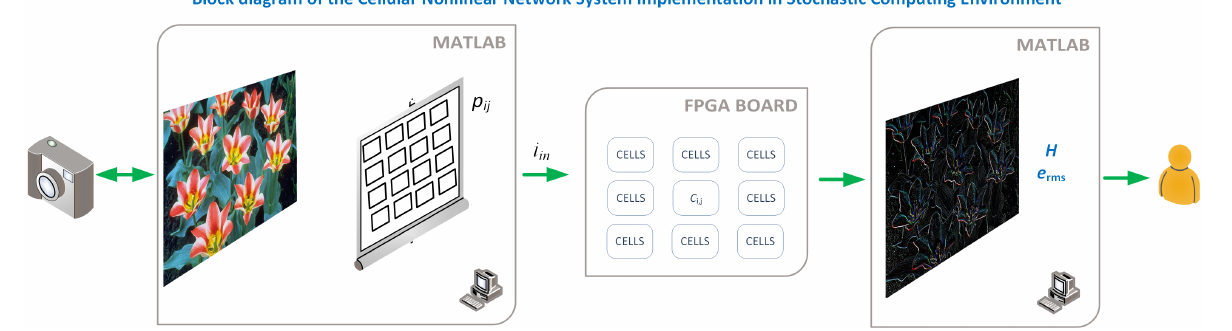
Figure 1. Conceptual depiction of the system, showing the tasks assigned to Matlab and those performed by the FPGA. The FPGA and Matlab are used jointly by using the FPGA-in-the-loop tool from Matlab, where the VHDL code is automatically generated, uploaded, and integrated with the main script at the